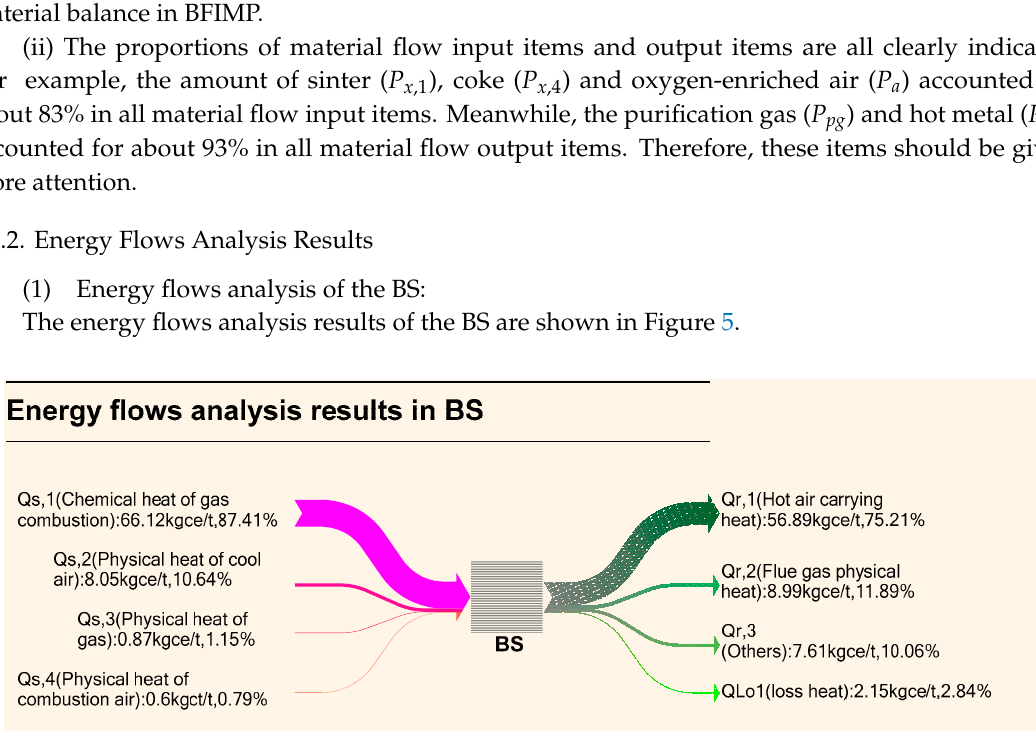
Figure 5. Energy flows analysis results in the blast system (BS).